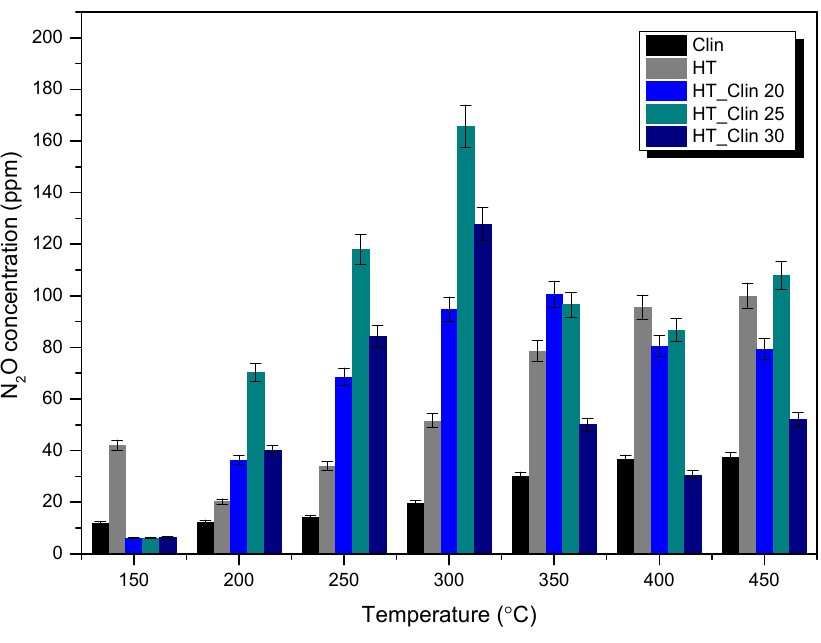
Figure 2. N 2 O concentration emitted during catalytic reaction over the samples.